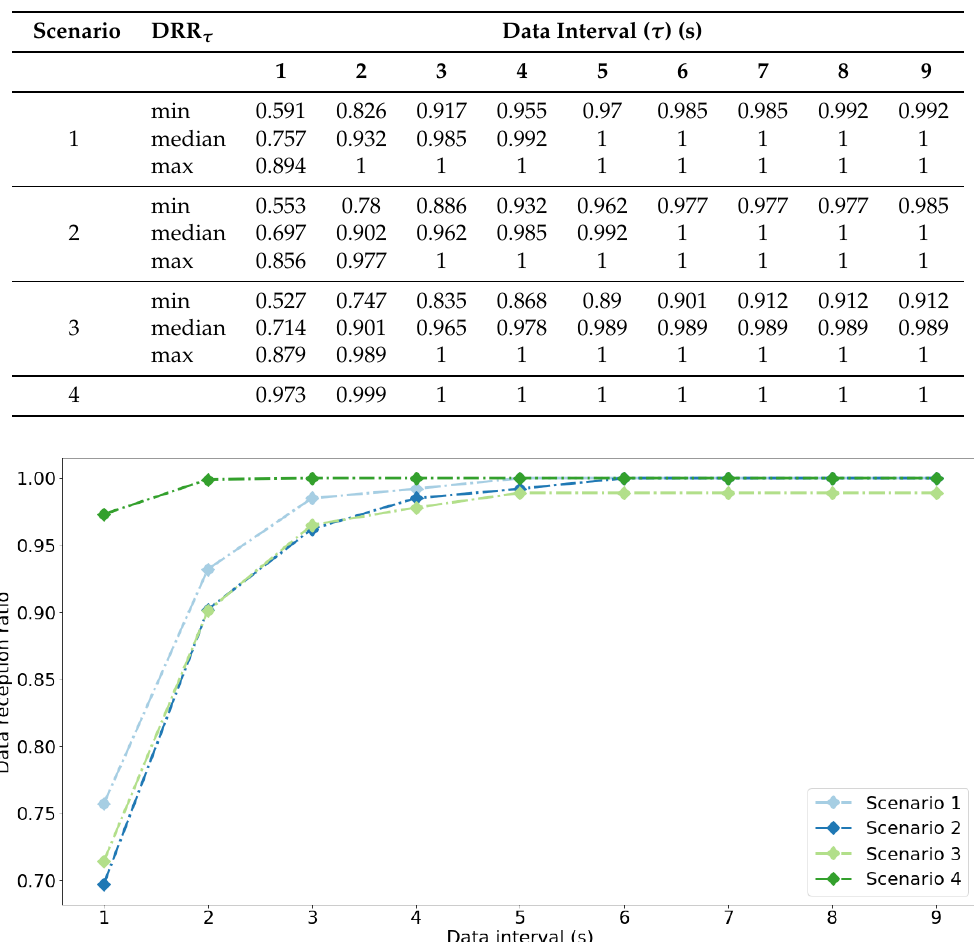
Table 7. Estimates of DRR τ for scanner S1, various scenarios, and data intervals τ < 10 s. For scenarios 1–3, the estimates are calculated for all the 150 nodes in the experiments. For scenario 4, estimates are calculated for a single node which was monitored during the experiments.